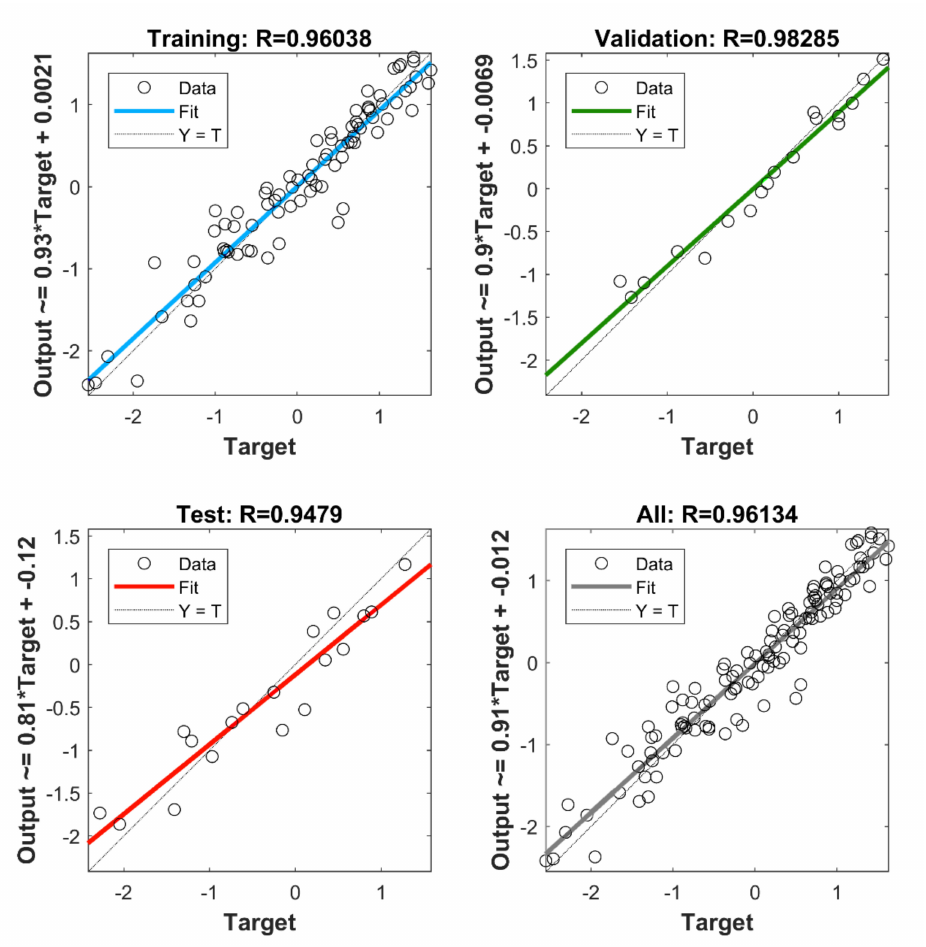
Figure 14. Regression plot of the evaluation